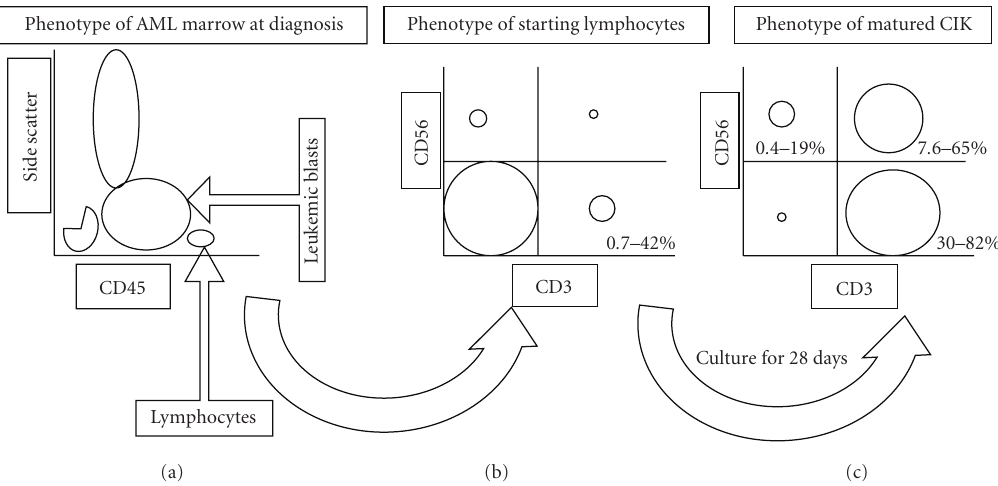
Figure 1: Marrow cells obtained from newly diagnosed AML samples analyzed by side scatter versus CD45 staining show a large proportion of leukemic blasts that are CD45 dim and a much smaller fraction of normal lymphocytes that are CD45 bright (a). Culture of the bulk marrow cells comprising of majority of leukemic blasts with a small fraction of lymphocytes under CIK condition (b) is able to generate an end product comprising of a majority of CD3 + cells with a variable CD3 + CD56 + fraction